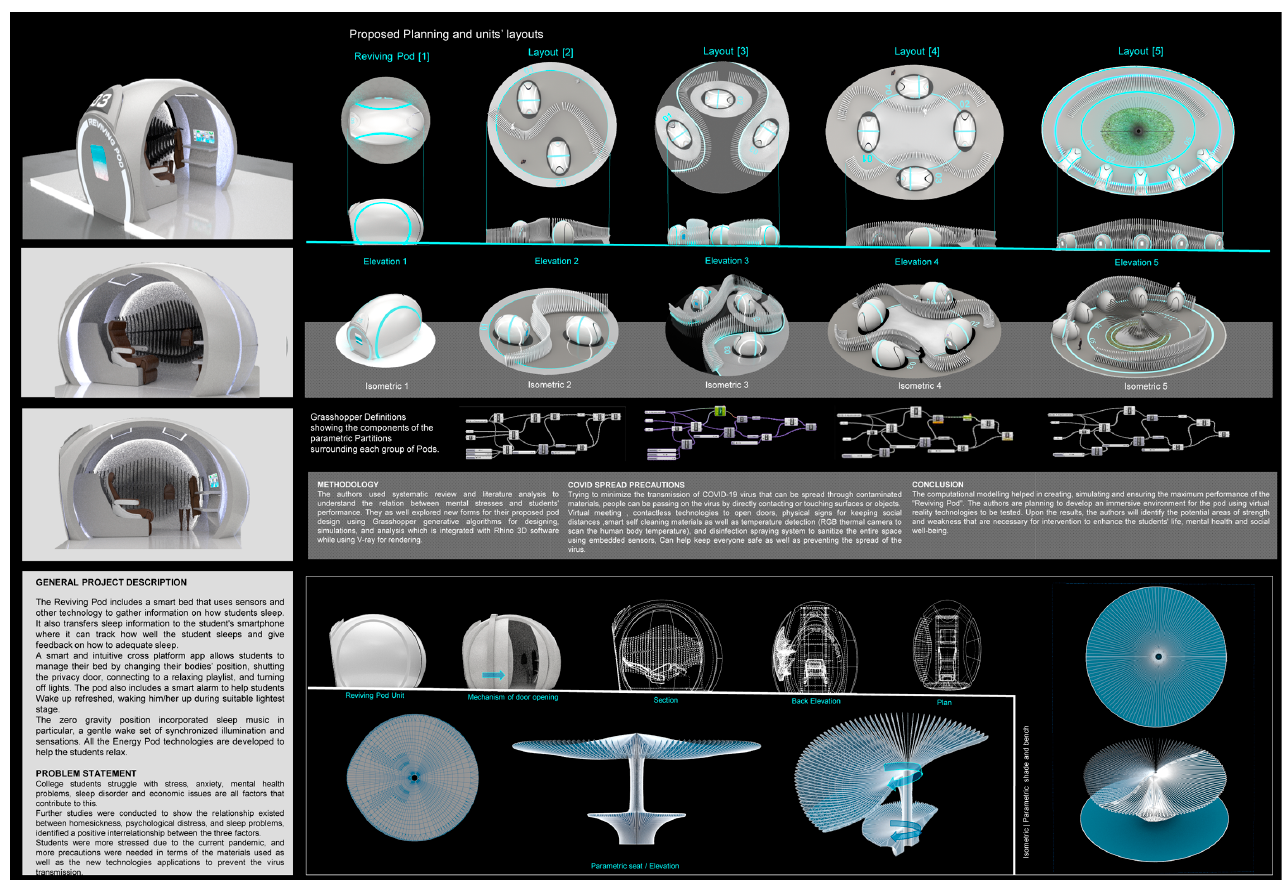
Figure A2 . Samples of the posters (Poster2) displayed on 6th of February 2022 on DAU campus in the CADD Female Exhibition. “Benyapa Prueksanusak, Punawatchara Rujivipatand, Konlakorn Wongpatikaseree, 2019” “Stella Collins, 2019” “Mingyu Park, Young-Hoon Song, Jeongyeup Paek, 2016” “ Julia Dellitt, Simon and Schuster, 2015.” “Andreas Holzinger, Martina Ziefle, Carsten Röcker, 2014” “Psychologists, Steven P. Gilbert & Cameron C. Weaver, 2010” “Taub, John